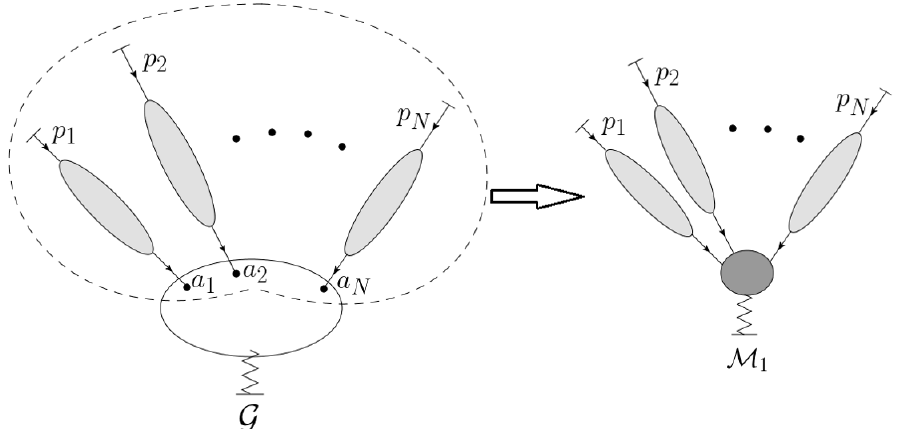
Figure 18. The schematic interpretation of Step 1 . In the entire graph G , the whole (cid:13)ow starts from the external momenta and ends at the hard vertices a 1 ; : : : ; a N . By contracting a i ( i = 1 ; : : : ; N ) into a hard vertex we obtain M 1